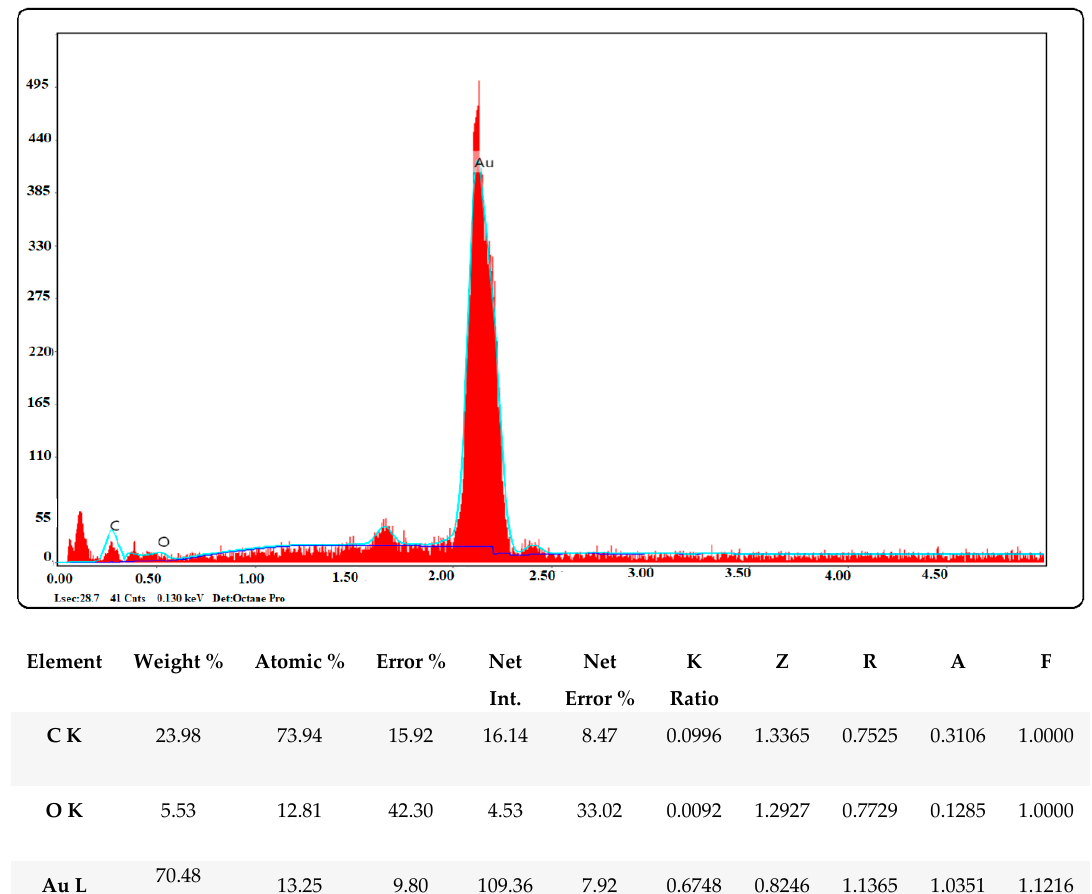
Figure 5. Elemental profile (EDX) of gold nanoparticle synthesis with Amygdalus communis leaf ex- tract.